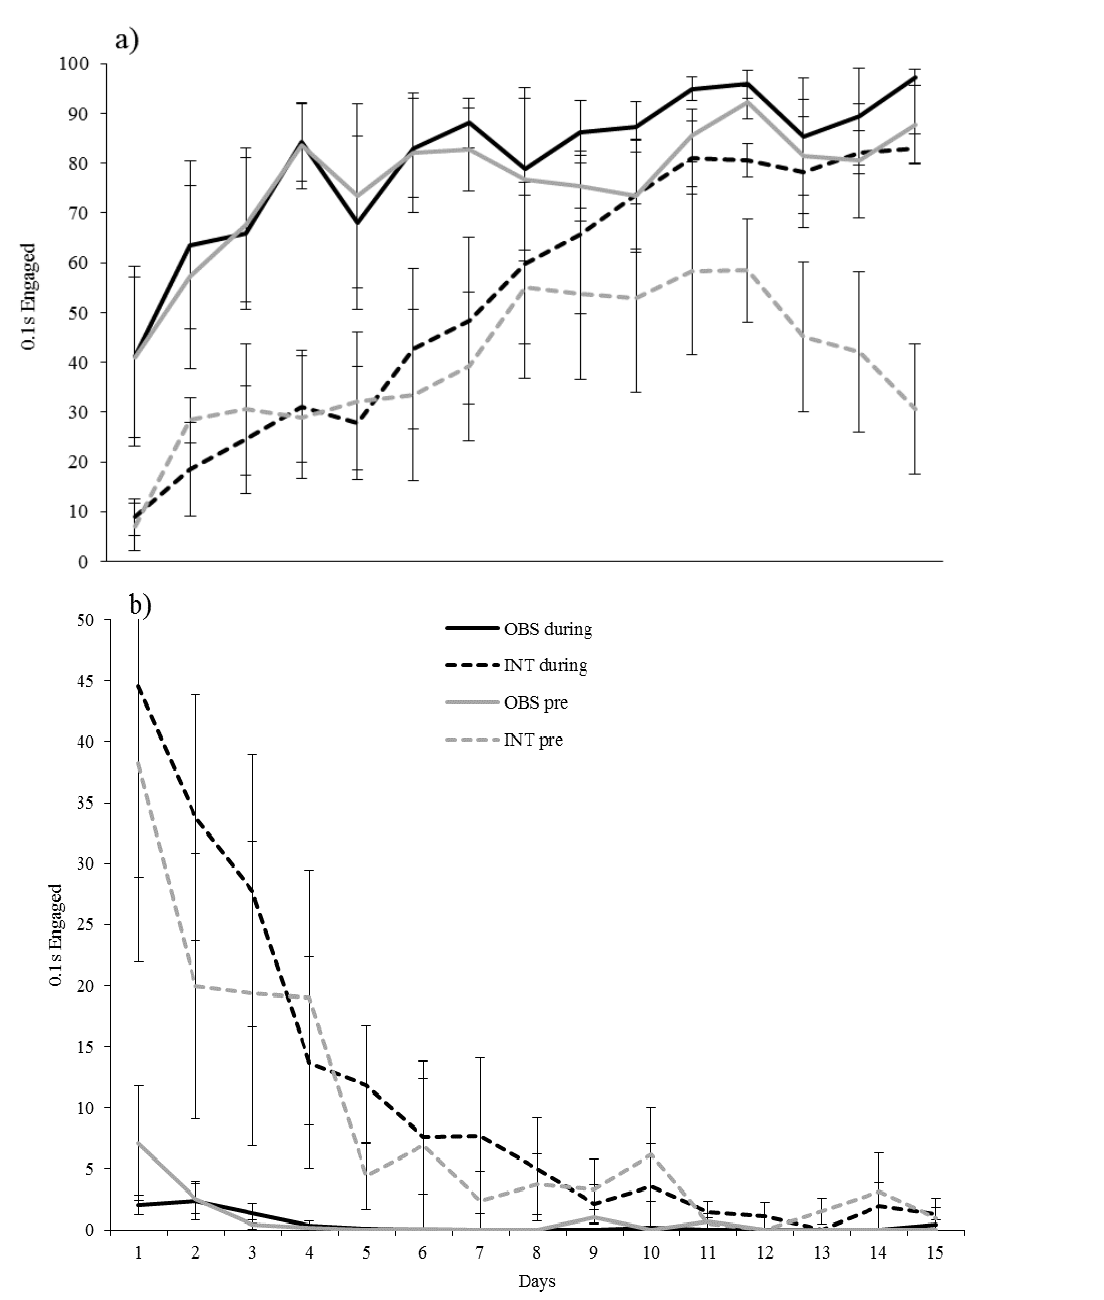
prior to and during presentations, over the 15 days of training. Error bars indicate